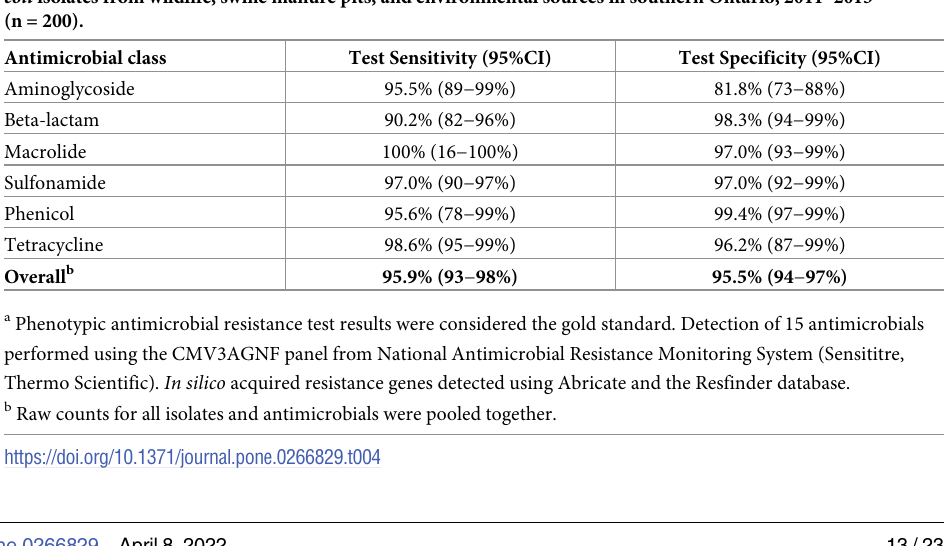
Table 4. Test sensitivity and specificity a for in silico identification of antimicrobial resistance genes in Escherichia coli isolates from wildlife, swine manure pits, and environmental sources in southern Ontario, 2011–2013 (n = 200). Antimicrobial class